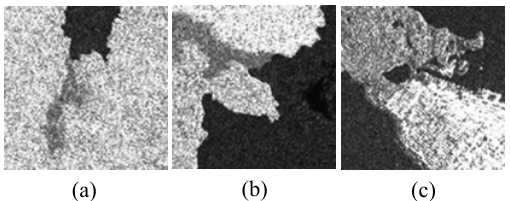
Figure 4. Real SAR images, (a) - (b) sea ice and (c) urban